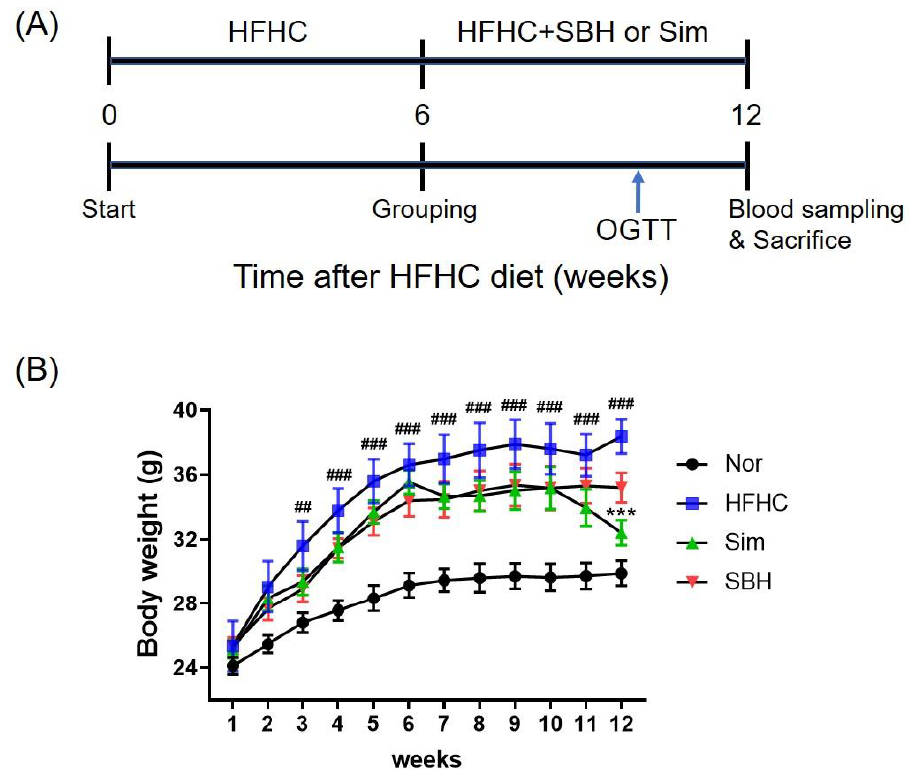
Figure 2. Effect of SBH on the changes in body weights in HFHCD-induced obese mice. Male mice were fed normal chow (Nor, n = 8) or HFHCD for 6 weeks, and then were administered HFHCD with Sim as a positive control (Sim, 5 mg/kg/d, n = 7), SBH (100 mg/kg/d, n = 7), or a vehicle (HFHC only, n = 7), as depicted in the experimental schedule ( A ). Body weights of the experimental mice were measured every week during the entire experimental period ( B ). Significant differences between the groups were assessed using two-way ANOVA with Tukey’s multiple comparison test. ## p < 0.01, ### p < 0.001 compared with Nor; *** p < 0.001 compared with HFHC. Nor, normal control group; HFHC, high-fat and high-cholesterol diet group; Sim, HFHC diet plus Sim group; SBH, HFHC diet plus SBH group.